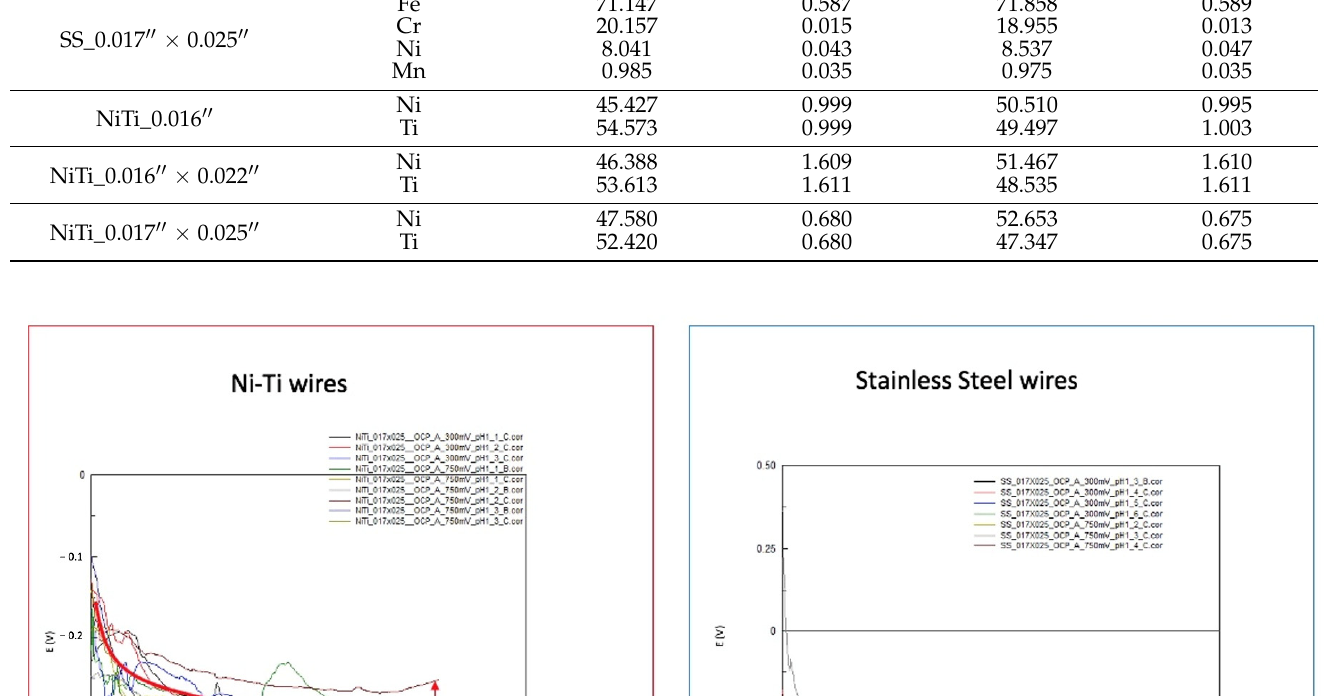
Table 2. The alloy composition mean values of the four different types of wires.